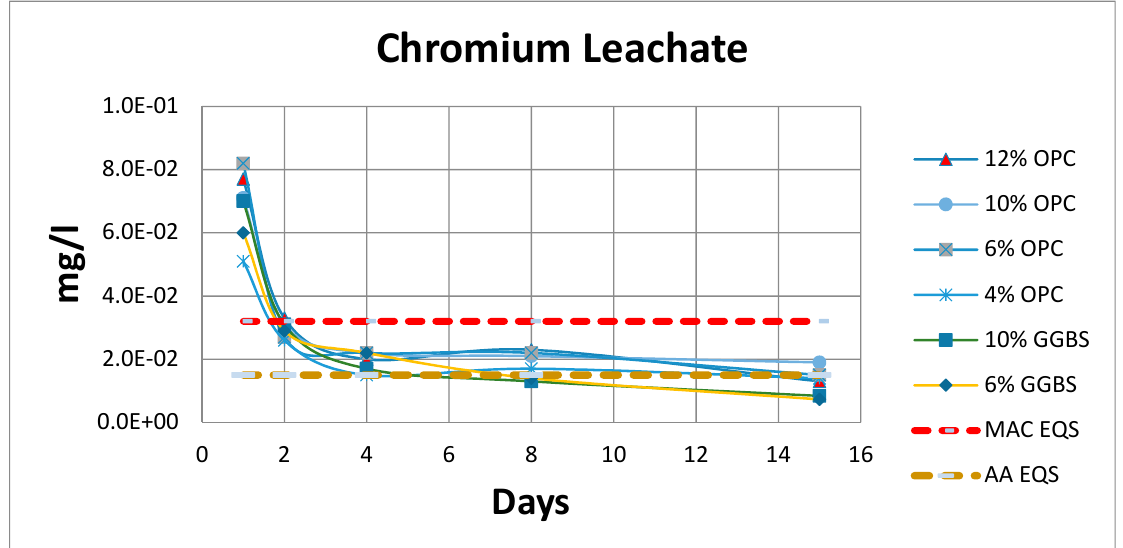
Figure 4. Chromium leachate from stabilised material.